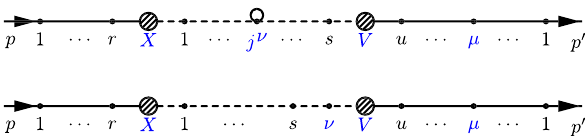
Fig. 8 Diagrams contributing to K photon insertion with vertex μ arbitrarily on the final fermion (solid) line and vertex ν on the inter- mediate scalar (dashed) line. The first diagram represents s possible contributions from the insertion of a circled vertex, j ν on the scalar line, j = 1 ,..., s . The second diagram is the contribution when the vertex ν is inserted just to the left of vertex V for a given location of vertex